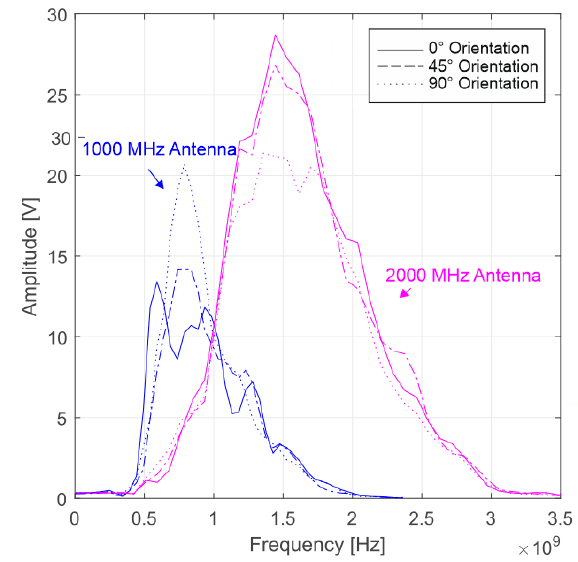
Figure 6. Frequency-domain response collected using the 1000 MHz (blue) and 2000 MHz (magenta) antennas with 0° (solid line), 45° (dashed line) and 90° (dotted line) orientations.